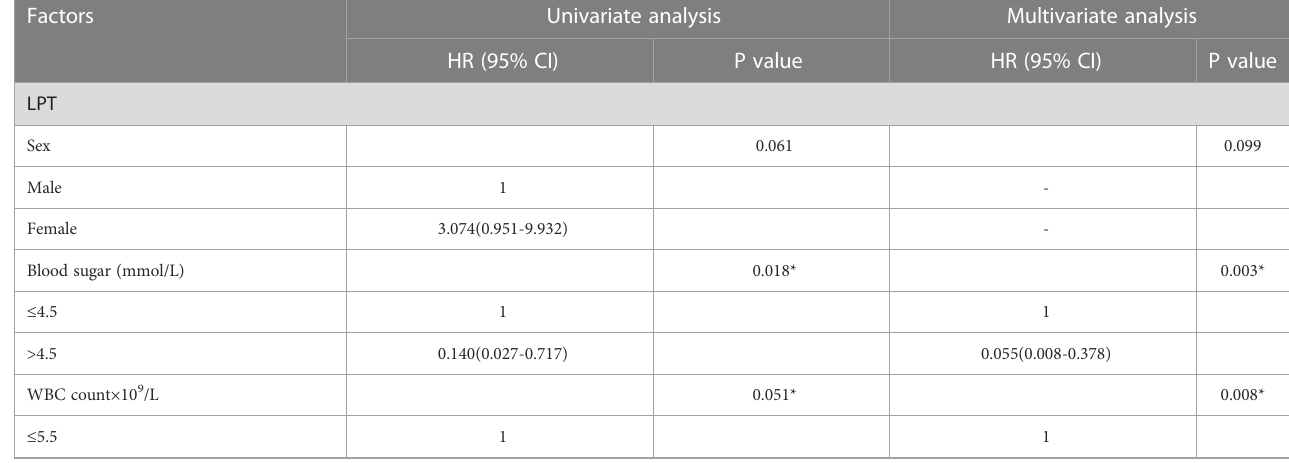
TABLE 3 Univariate and multivariate analysis of the prognostic factors for different recurrence patterns in the entire study population (N =